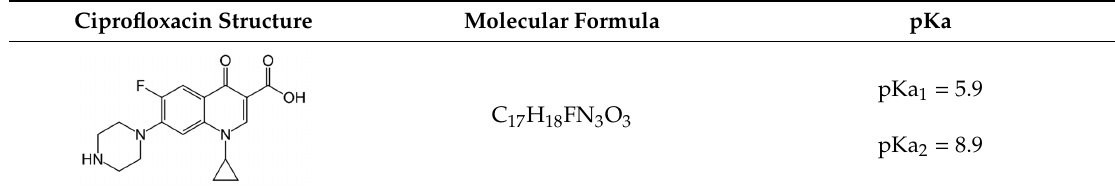
Table 1. Structural and chemical properties of ciprofloxacin and its pKa [3,13]. Ciprofloxacin Structure